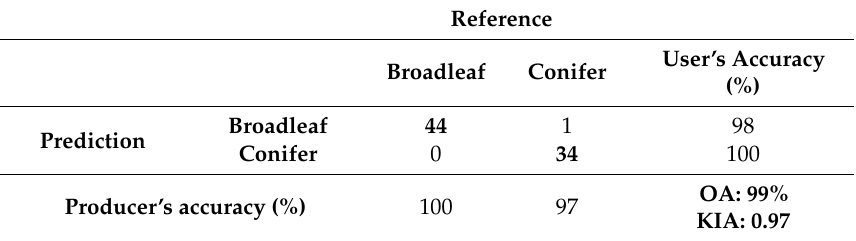
Table 10. Confusion matrix of the RF model for the hierarchical approach: binary classification of tree type (broadleaf / conifer). OA: Overall accuracy, KIA: Kappa Index of agreement.